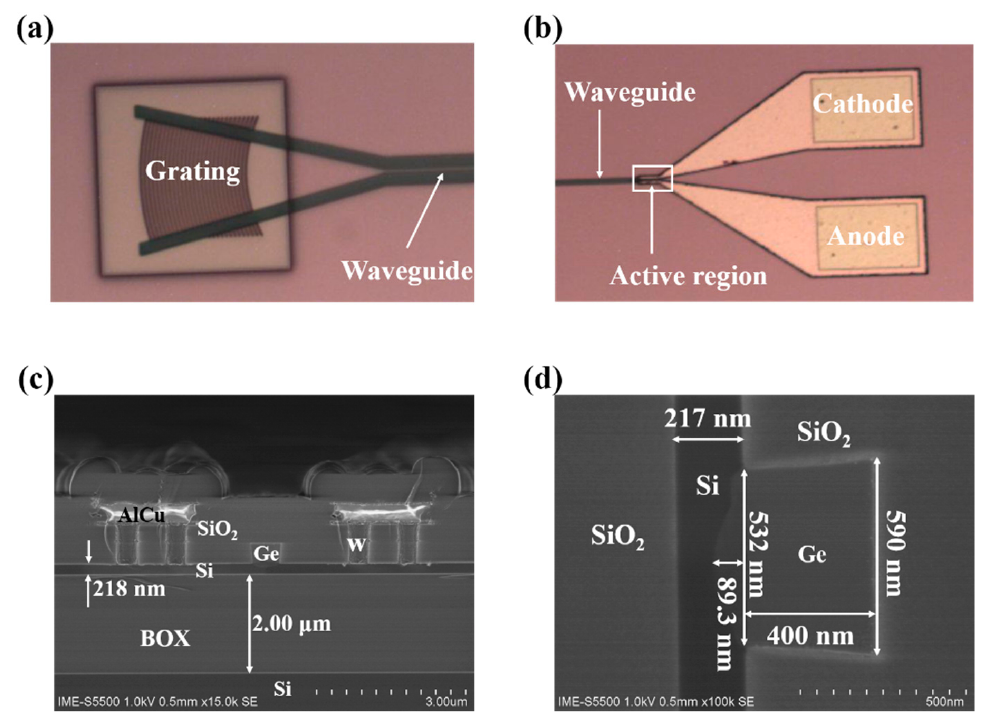
Figure 4. ( a ) Optical microscopy image of the grating; ( b ) Optical microscopy image of the active area of the device; ( c ) Cross-section SEM image of the active region; ( d ) Cross-section of the germanium region.